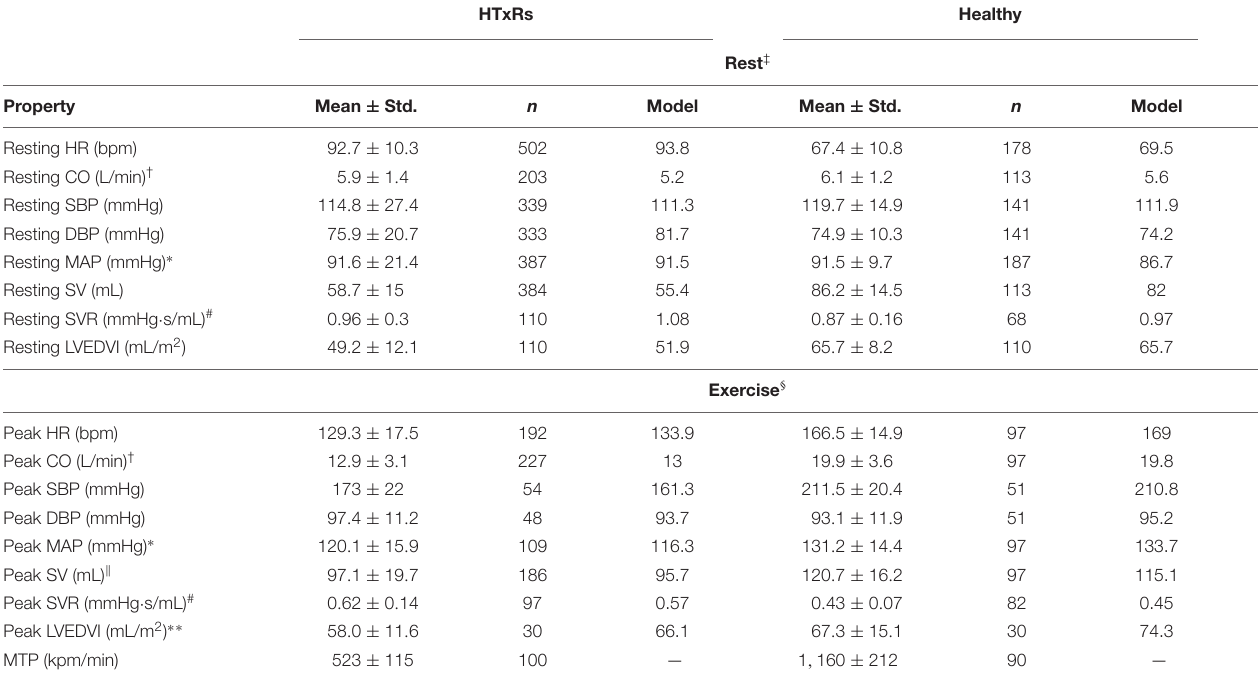
TABLE 1 | Pooled means and variances of hemodynamic variables for HTxRs and matched healthy controls derived from literature compared to simulation results. HTxRs Healthy Rest ‡ Property Mean ± Std.